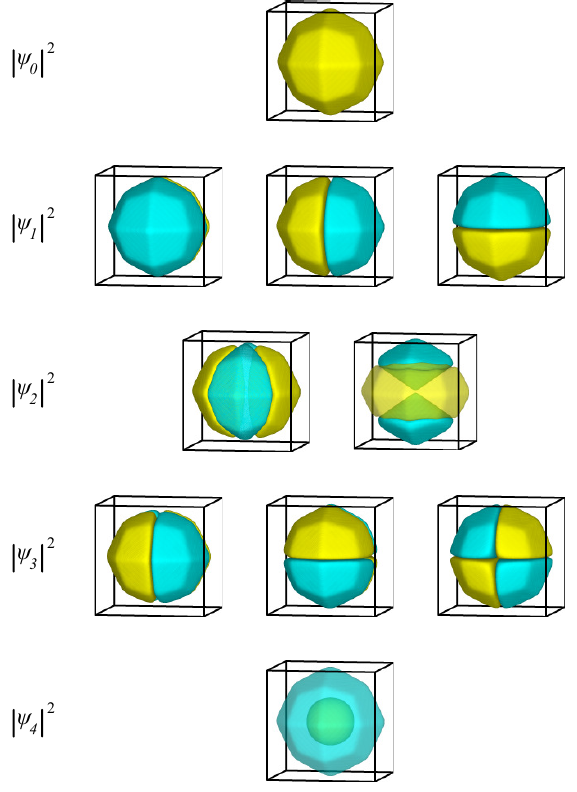
Figure 5. The probability function, | ψ | 2 , of the first ten eigenstates of an electron inside a thiolate-protected Au nanoparticle. Yellow represents positive and cyan negative values of the